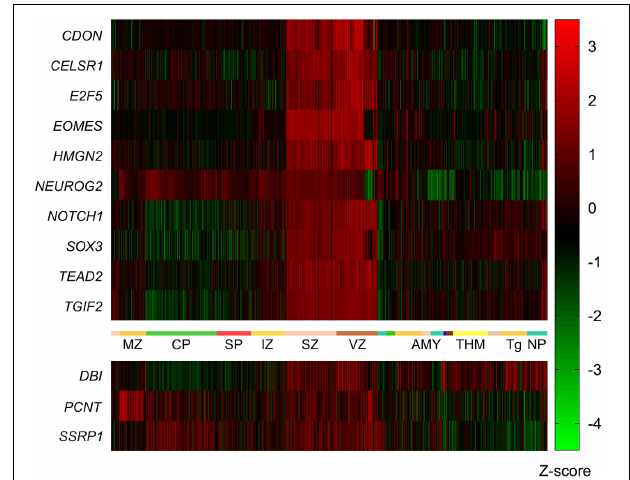
FIGURE 3 | Expression of mouse VZ network genes in different areas of the human developing brain (15–20 post-conception weeks). Genes with significantly higher expression in the ventricular and subventricular zone (VZ and SVZ respectively) compared to all other brain regions were identified using the prenatal laser microdissection (LMD) microarray dataset from the BrainSpan atlas of the developing human brain. Resulting gene lists were then compared to those genes identified in mice. We found that ten of the 13 mouse genes were significantly more highly expressed in the human VZ and SVZ, namely CDON , CELSR1 , E2F5 , EOMES , HMGN2 , NEUROG2 , NOTCH1 , SOX3 , TEAD2 , and TGIF2 . The other three genes— DBI , PCNT , and SSRP1 —were not enriched in the human VZ or SVZ. MZ, marginal zone; CP, cortical plate; SP, subplate zone; IZ, intermediate zone; SZ, subventricular zone; VZ, ventricular zone; AMY, amygdaloid complex; THM, thalamus; Tg, tegmentum; NP, neural plate.